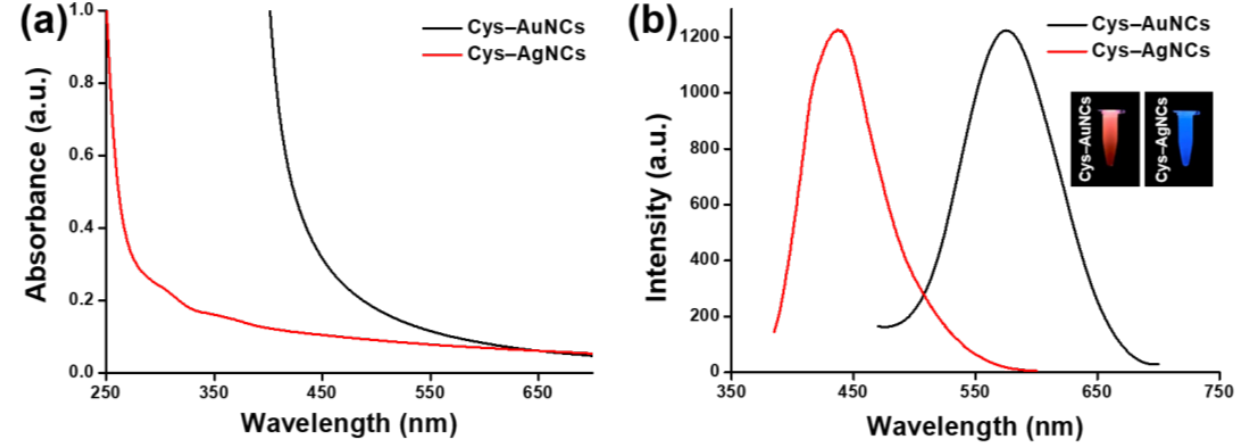
Figure 2. ( a ) UV–Vis absorption spectra of the Cys–AuNCs (black) and Cys–AgNCs (red). ( b ) Fluorescence spectra of the Cys–AuNCs (black) and Cys–AgNCs (red). The insets illustrate the orange-red fluorescence of the Cys–AuNCs (left) and blue fluorescence of the Cys–AgNCs (right) under irradiation from a hand-held UV lamp. To further confirm that the cysteine conjugated with the AuNCs, the cysteine, Cys– AuNCs, and Cys–AgNCs were characterized using Fourier transform infrared (FTIR) spectroscopy (Thermo Scientific Nicolet iS10, Waltham, MA, USA). s shown in Figure 3, the characteristic IR bands of cysteine were obtained, including a broad stretching band of NH 3+ ( ≈ 2974 cm − 1 ), a stretching band of SH ( ≈ 2551 cm − 1 ), an asymmetric stretching band of COO − ( ≈ 1585 cm − 1 ), and a bending vibration of NH ( ≈ 1536 cm − 1 ). After the conjugations of the cysteine and metallic nanoclusters, the characteristic IR bands of the cysteine in the Cys–AuNCs and Cys–AgNCs presented a small shift compared to those of cysteine due to the change in the dipole moment of the cysteine conjugated onto metallic nanoclusters [44]. Most importantly, the stretching band of SH of the cysteine vanished because Au–S and Ag–S covalent bonds were generated in both the Cys–AuNCs and Cys–AgNCs [45,46]. Overall, the results from the TEM images, UV–Vis absorption spectra, fluorescence spectra, and FTIR analyses indicated that the fluorescent Cys–AuNCs and Cys–AgNCs were successfully synthesized using the facile hydrothermal